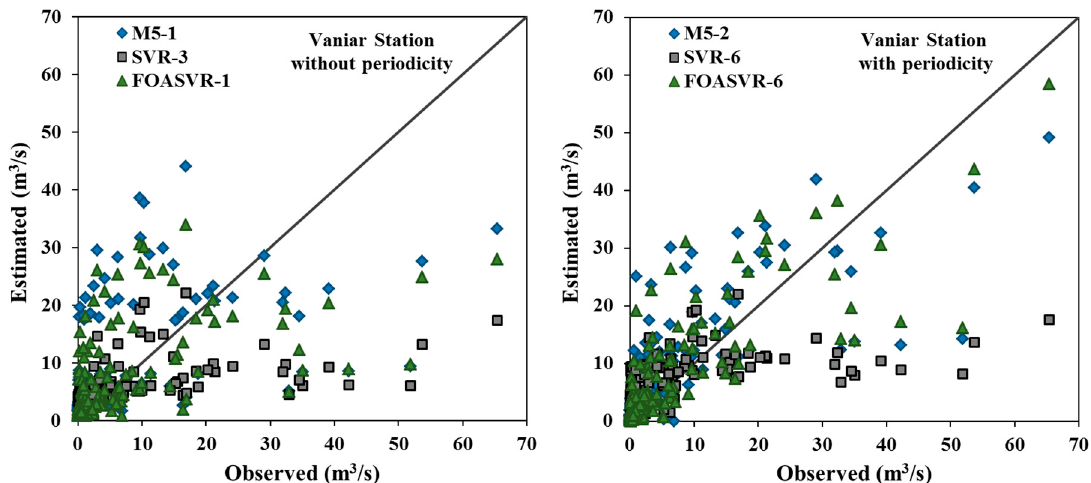
Figure 9. The scatter plots of the observed and forecasted monthly river flows. ( a ) Babarud station without periodicity, ( b ) Babarud station with periodicity, ( c ) Vaniar station without periodicity, ( d ) Vaniar station with periodicity.